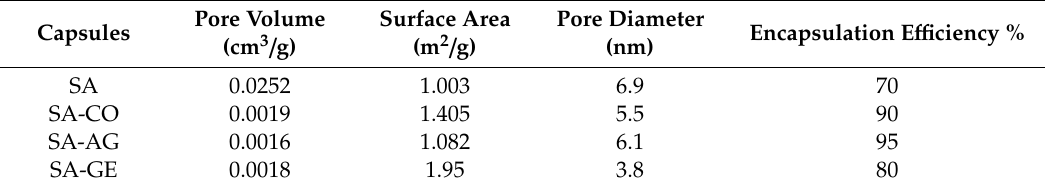
Table 1. Capsules pore dimensions and encapsulation e ffi ciency.